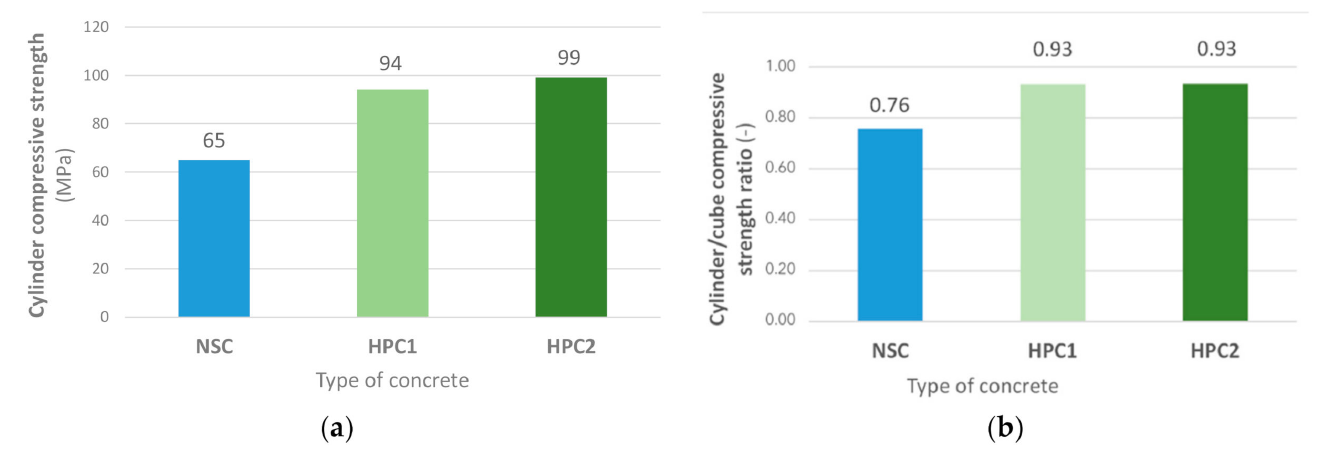
Figure 2. Comparison of cylinder compressive strength ( a ) and cylinder/cube compressive strength ratio ( b